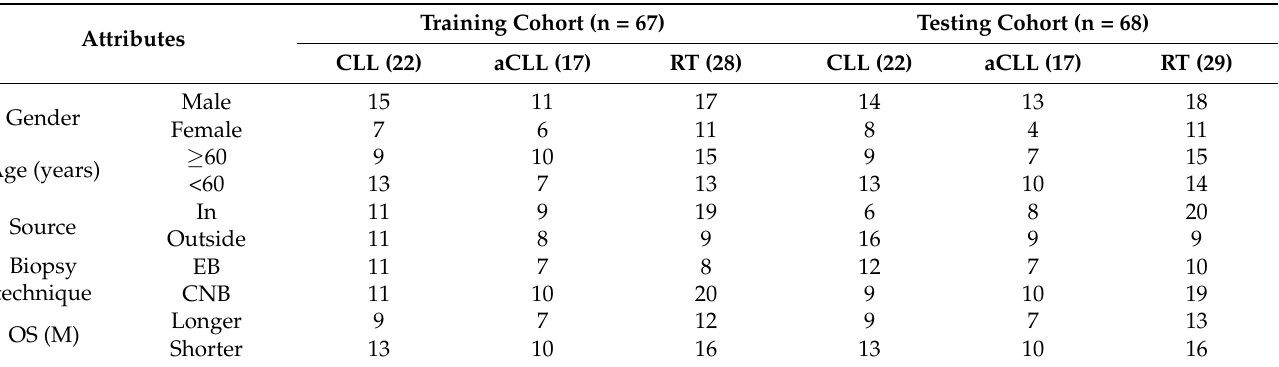
Table 1. Training and testing cohorts splitting based on patients’ gender, age, source, biopsy technique, and overall